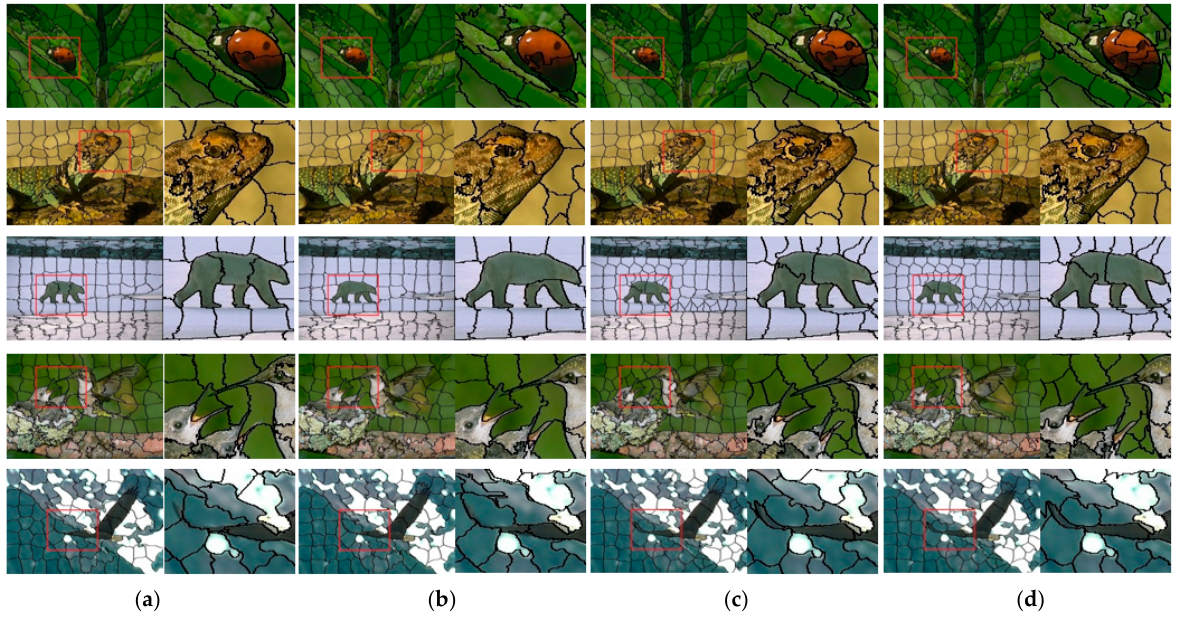
Figure 10. Visual results of superpixels on BSDS500. Each column represents superpixels generated by ( a ) SNIC; ( b ) BA-SNIC; ( c ) CA-SNIC; ( d ) BACA. The excepted number of superpixels is fixed to